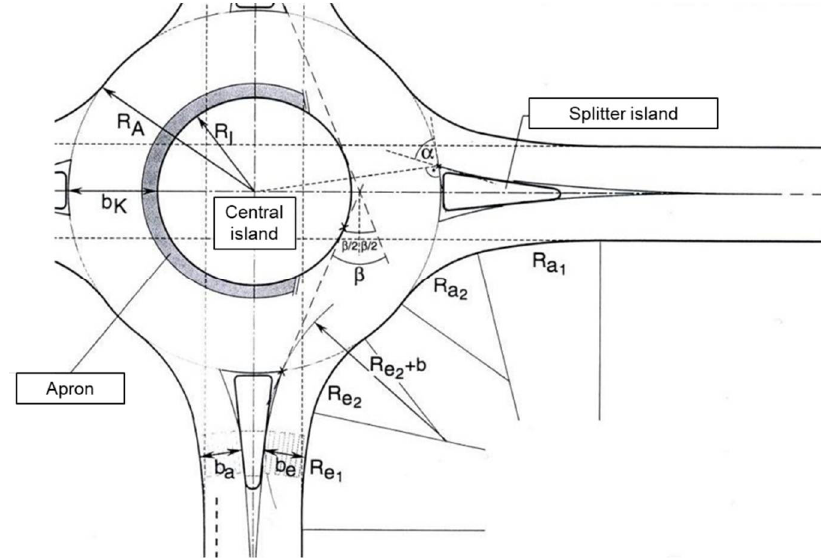
Figure 26. Design elements for single-lane roundabout entry and exit according to [12].